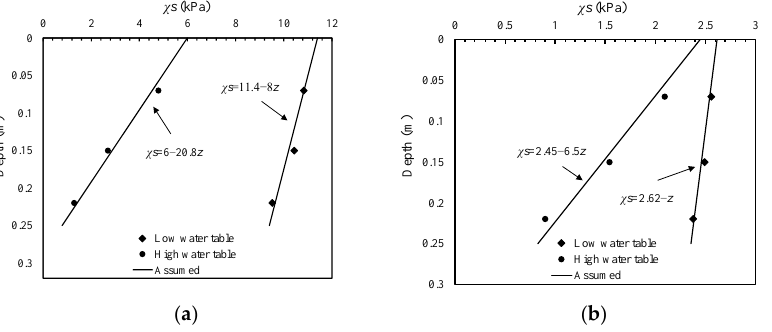
Figure 8. Assumed χs profiles for unsaturated soil samples subjected to ( a ) drying; ( b ) wetting.